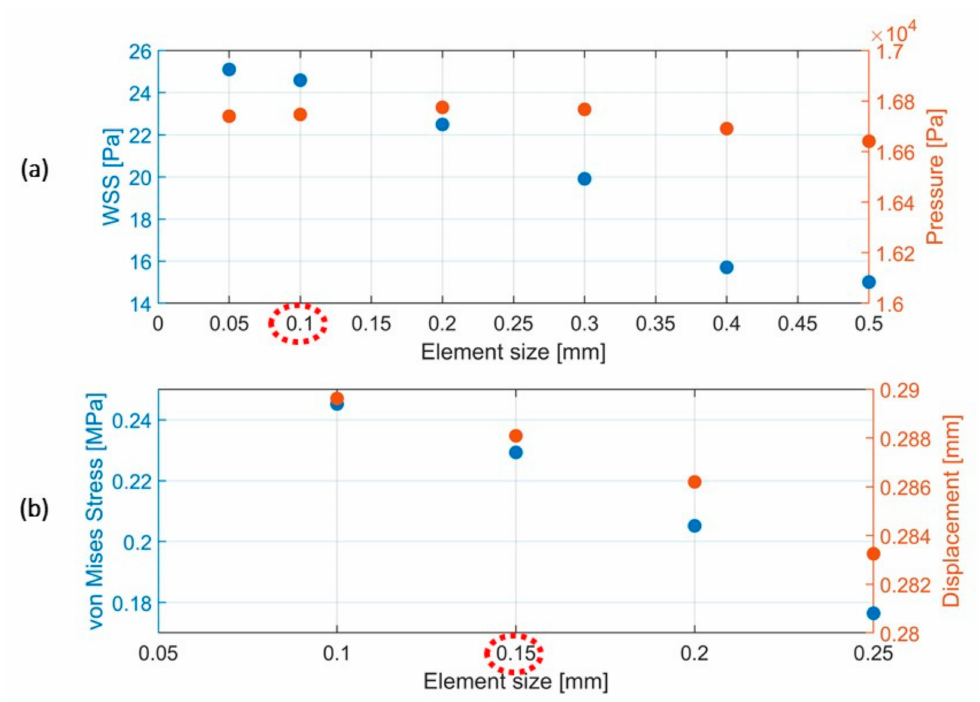
Figure 5. ( a ) For the fluid domain, comparison of WSS and pressure values on aneurysm surface at systole time according to different mesh element sizes. Unlike pressure, WSS was relatively sensitive to mesh element size. The chosen optimal value was 0.1 mm. ( b ) For the solid domain, comparison of von Mises stress and displacement values on aneurysm at systole time according to different mesh element sizes. The chosen optimal value was 0.15